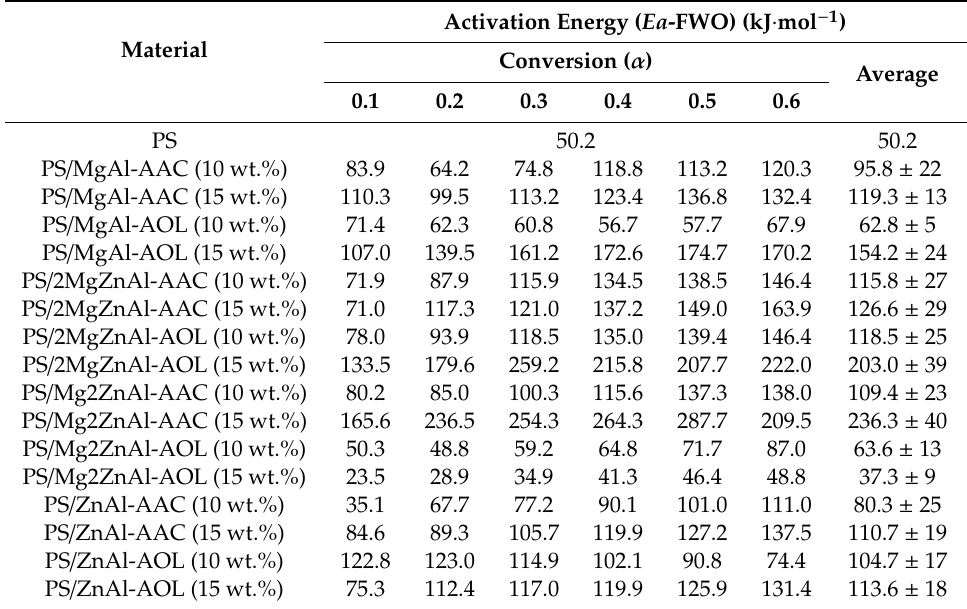
Table 7. Activation energies obtained using the Flynn–Wall–Ozawa method.